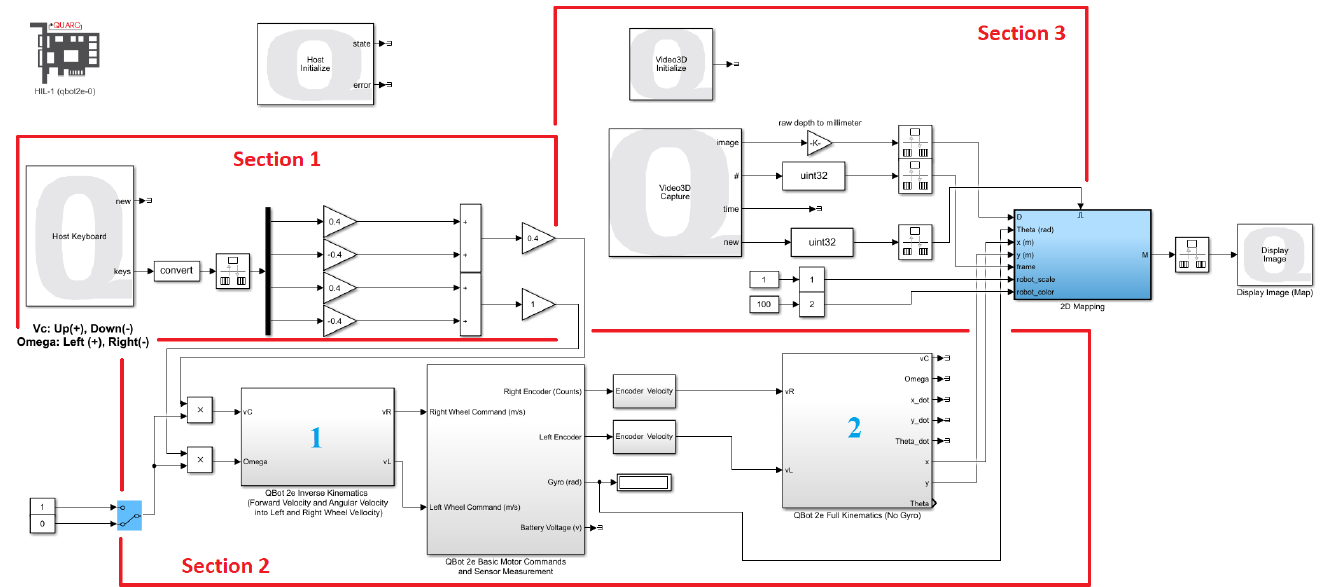
Figure 5. Simulink diagram for controller model for the mapping of QBot